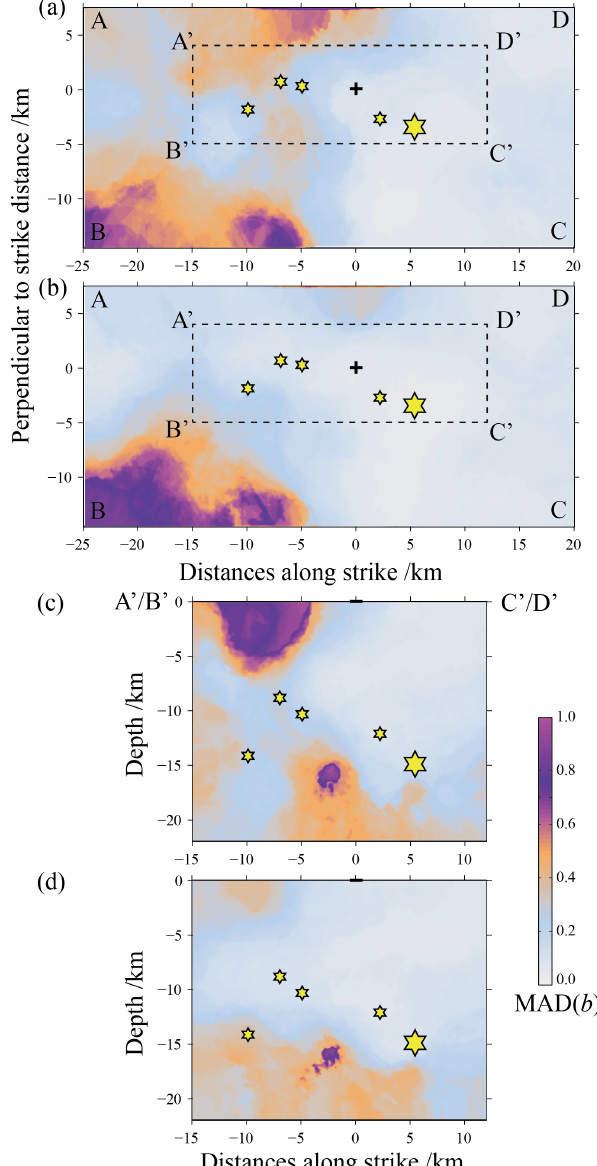
Figure 5. The spatial distribution of the median absolute devia- tion (MAD) of the b values by the data-driven approach according to Fig. 4. (a) The ensemble MAD b values before the Changning M S = 6 . 0 earthquake is distributed on the horizontal plane after the rotation; (b) the ensemble MAD b values obtained by calculation of the whole earthquake including the aftershocks of the Changn- ing M S = 6 . 0 earthquake distributed on the horizontal plane after the rotation; (c) distribution of the ensemble MAD b values before the occurrence of the Changning M S = 6 . 0 earthquake in the rect- angular frame A (cid:48) B (cid:48) C (cid:48) D (cid:48) on the depth profile; (d) distribution of en- semble MAD b values obtained by calculation of all earthquakes including aftershocks of the Changning M S = 6 . 0 earthquake in the rectangular frame A (cid:48) B (cid:48) C (cid:48) D (cid:48) on the depth